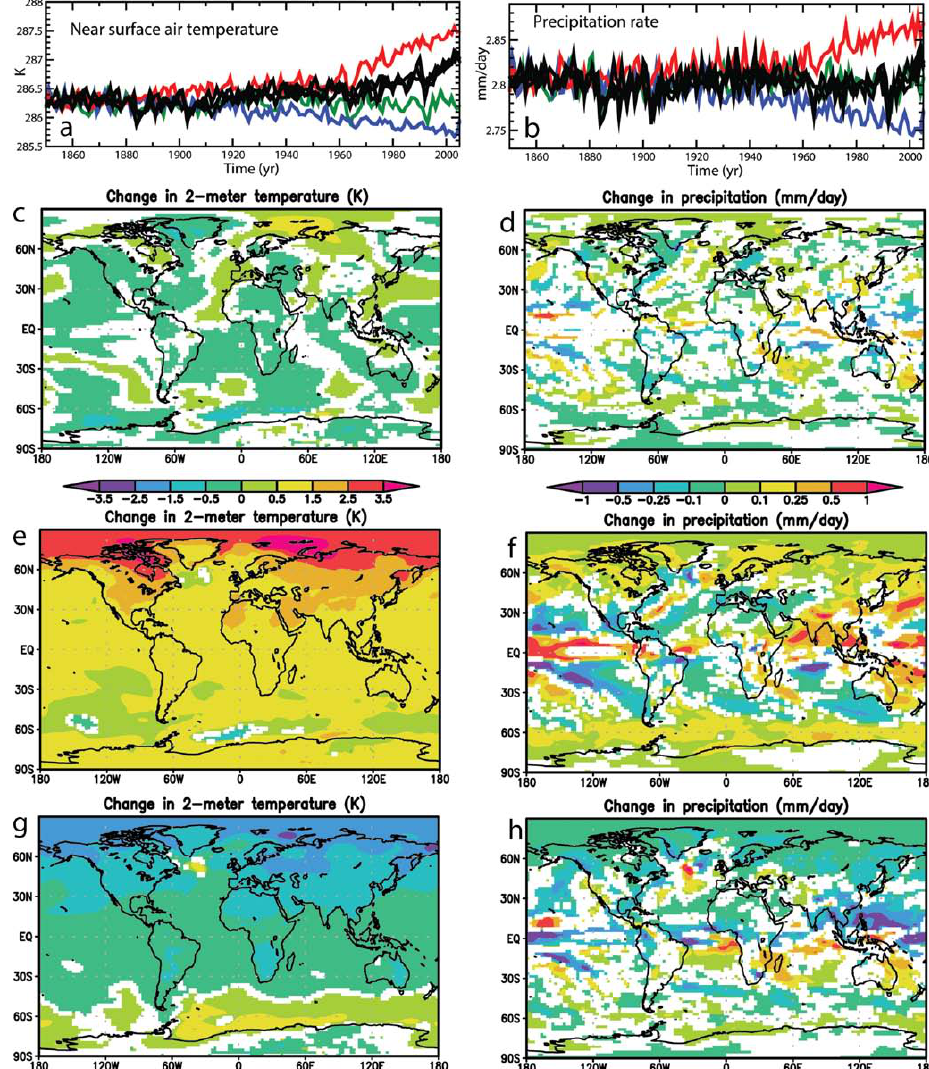
Fig. 4. NorESM1-M single forcing simulations of the historical period 1850–2005 and for the period 1976–2005 compared to piControl. Response in annual mean surface air temperature (left panels a , c , e , g ) and average daily precipitation amounts (right panels, b , d , f , h ). The graphs in the top panels ( a and b ) show global annual values from 1850 to 2005 for Historic1, 2, and 3 with full forcing (black), with natural forcing only (green), GHG-forcing only (red), and aerosol-forcing only (blue). The maps in the six panels below show changes between piControl and 1976–2005 for natural forcing only ( c and d ), GHG-forcing only ( e and f ), and aerosol forcing only ( g and h ). White patches indicate areas where changes are not significant at the 95% confidence level (two-sided, Student t-test with respect to variance of annual values in